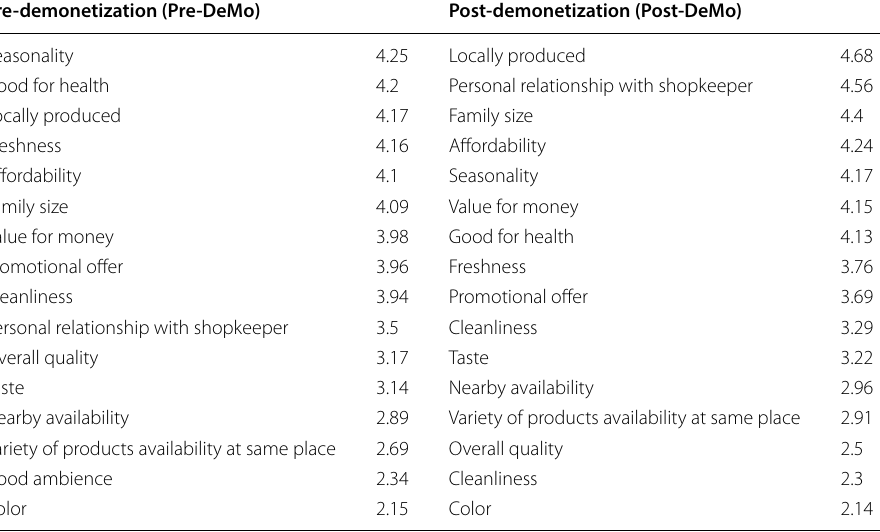
1 indicates “not at all important” and 5 indicates as “extremely important”